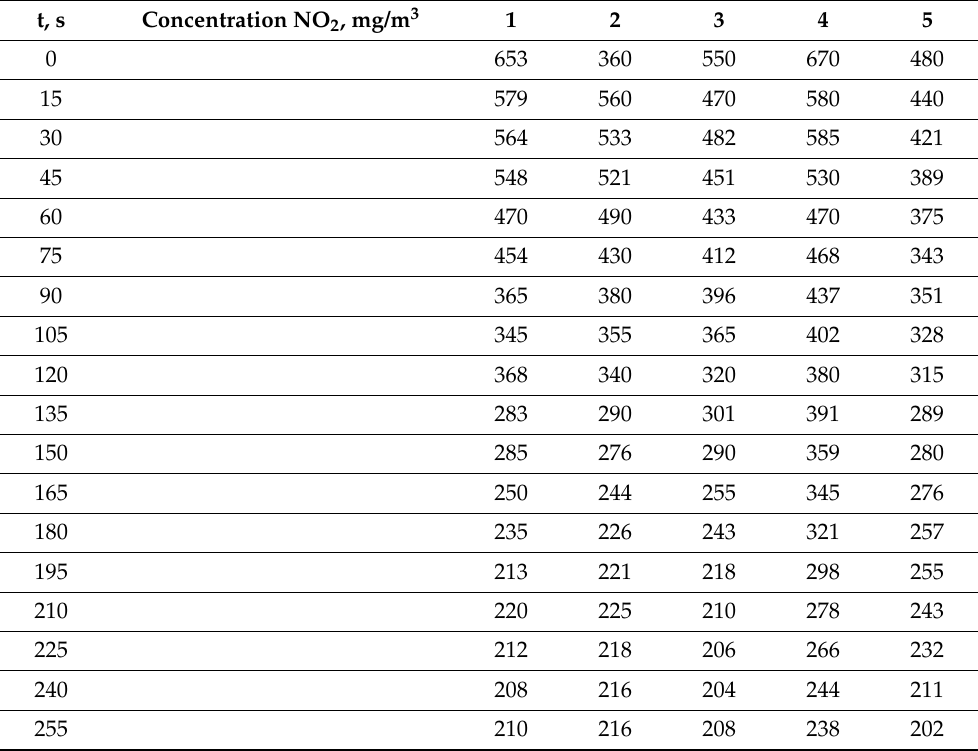
Table 1. Concentration of nitrogen oxides in explosion products of a sample of pentaerythritol tetranitrate weighing 1.02 g (compiled by the author R.S. Babkin).